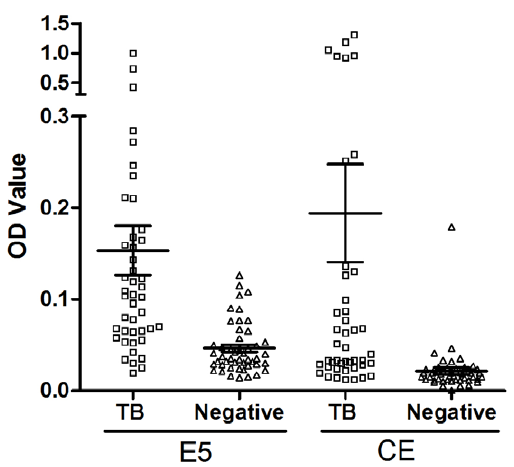
Figure 8. Scatter dot plot representation of the distribution of IgG levels to the peptide E5 and CE protein in TB patients ( % ) and negative control ( n ). (Error bars: 95% confidence interval for mean). The plates were coated with 4 m g peptides E5 ml 2 1 or 1 m g CE protein ml 2 1 per well, as described in Methods. Sera from TB patients (n=44) and healthy individuals (n=48) were tested. The results are shown as the mean OD value of each triplicate sample read 20 min after the addition of substrate. Significance was determined against the negative controls group of E5 peptides and CE protein (t=4.086, P , 0.0001; t=3.359, P=0.0011). The sensitivity and specificity of E5 peptide and CE protein were 54.5% and 91.7%, 34.1% and 97.9%, respectively, with a cut-off value at mean + 2SD of the healthy controls.